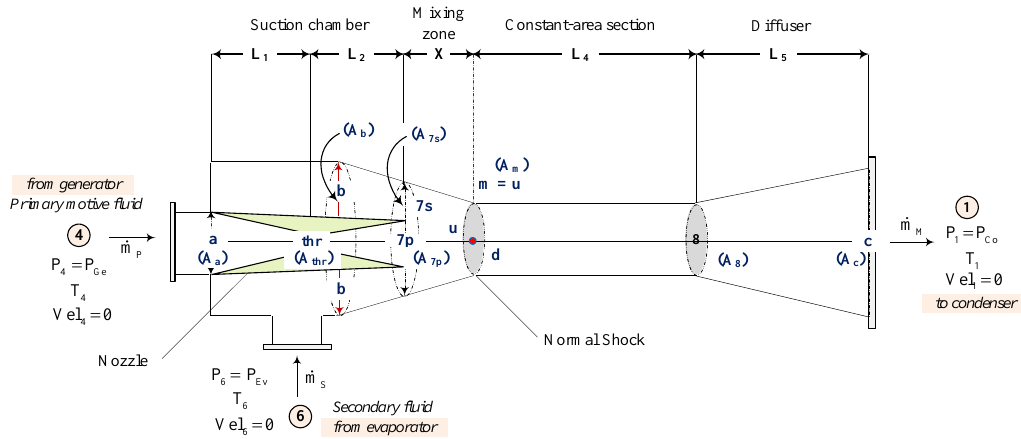
Figure 3. An ejector model with constant mixing pressure.